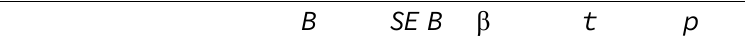
Model 2: analysis of the mediating role of self-regulation in the relationship between hostile/coercive and early mathematics B SE B β t p Outcome: